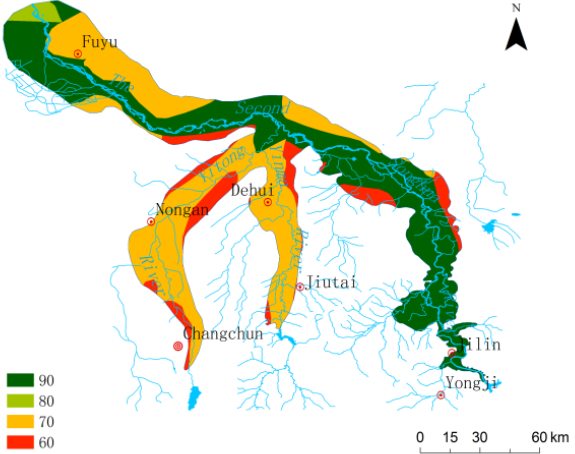
Figure A1. Distribution of hydraulic conductivity scores.